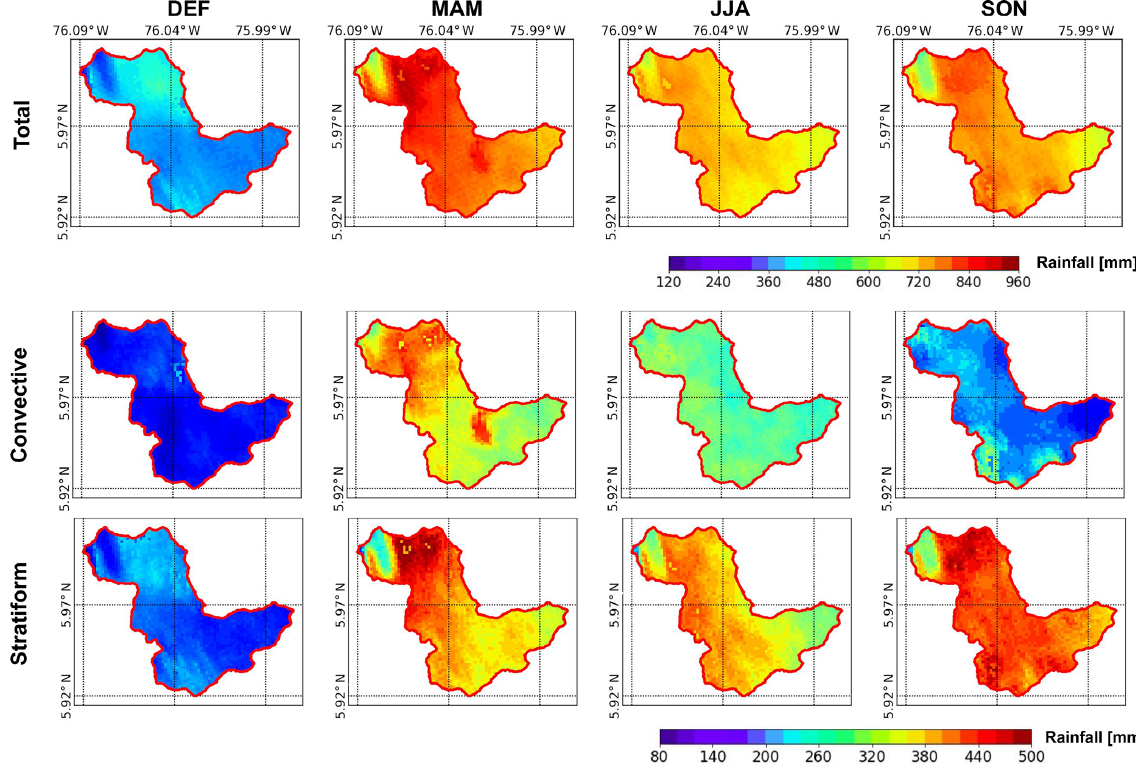
Figure 8. Precipitation climatology for the La Liboriana basin for the 2013–2018 period using the described QPE technique. The precipitation climatology is presented for the DJF, MAM, JJA, and SON trimesters, and it is discriminated in the portion associated with stratiform and convective precipitation using the Steiner et al. (1995)